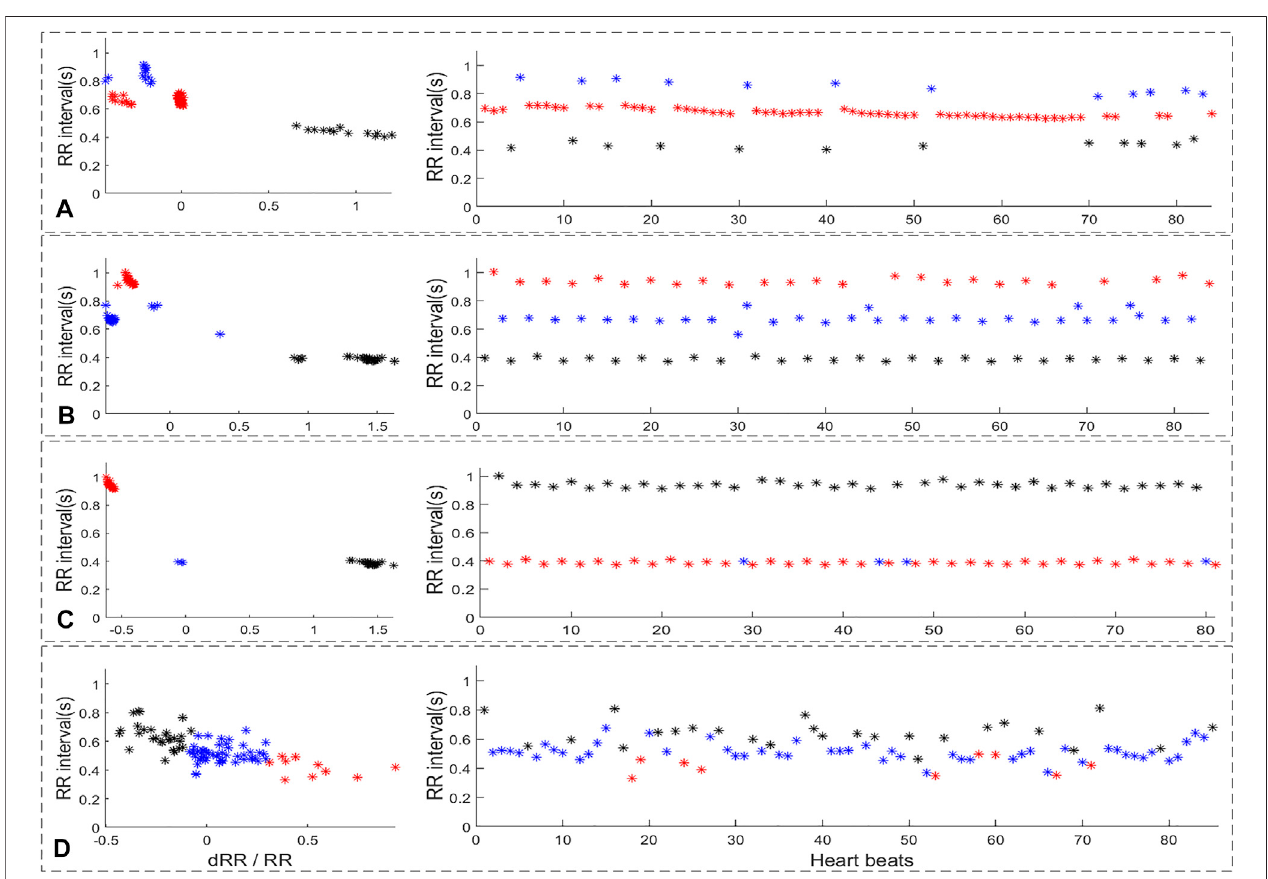
FIGURE 5 | The RR-interval based cluster analysis result of four different rhythm. (A) : multi-PB, (B) : trigeminy, (C) : bigeminy, (D) : AF.